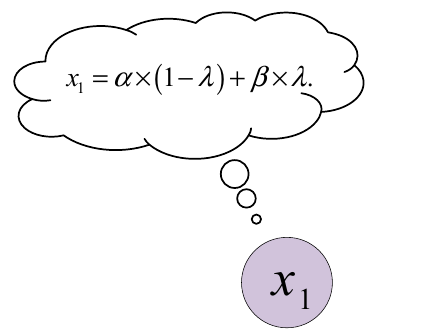
Figure 4. Golden section coefficient.